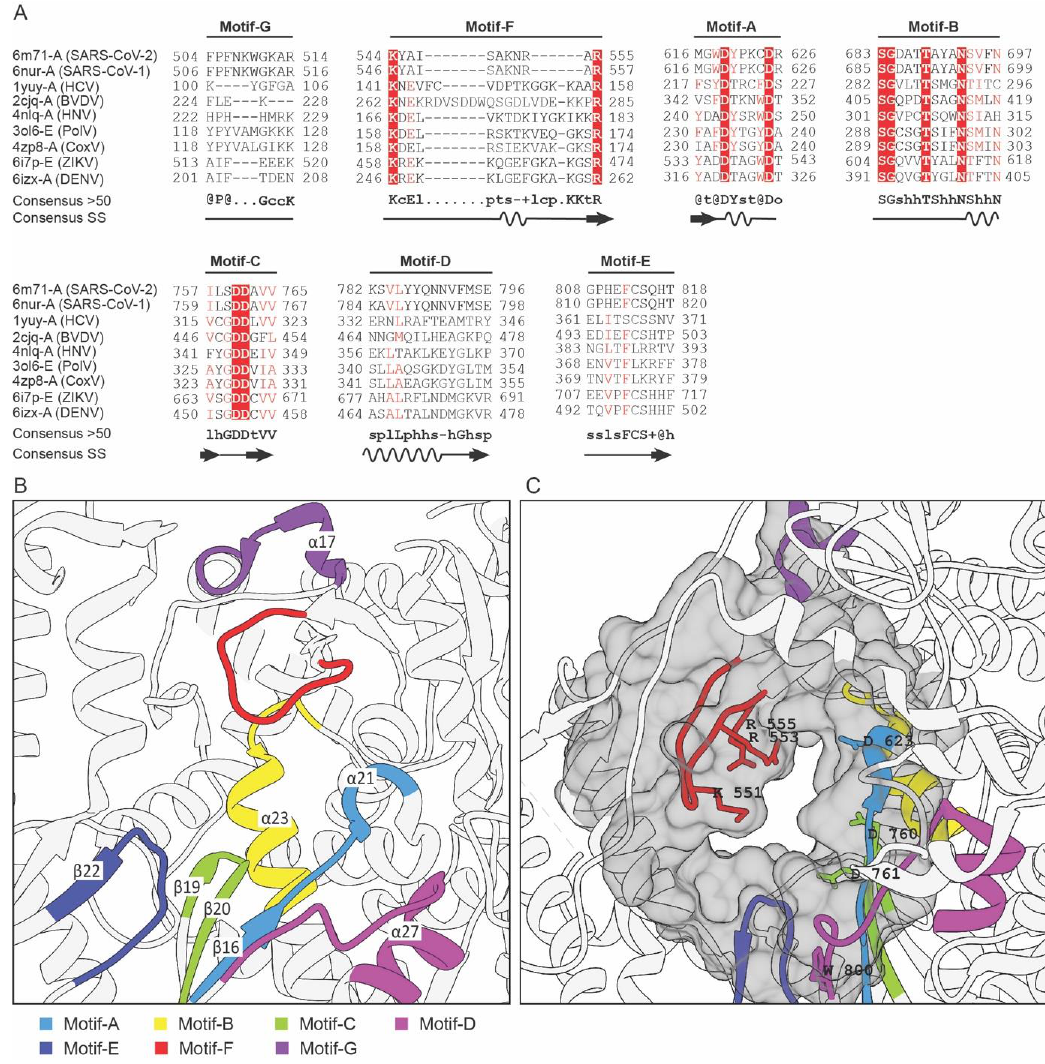
Figure 2. Analysis of the conserved motifs in NSP-12 and identification of druggable cavity. ( A ) Multiple sequences and secondary structure alignment of the homologous protein about NSP-12 of SARS-CoV-2 shows the conserved residues and secondary structure responsible for RdRp activity. Residues that have been highlighted in red are highly-conserved amino acids in the functional domain of RdRP protein. ( B ) Structurally and functionally conserved seven motifs A–G located at the active site of the RdRp domain of NSP-12. ( C ) The predicted druggable cavity at the active site of the RdRp domain of NSP-12. The predicted active residues participating in ligand interactions have been shown as a gray surface where the conserved residues are also located.